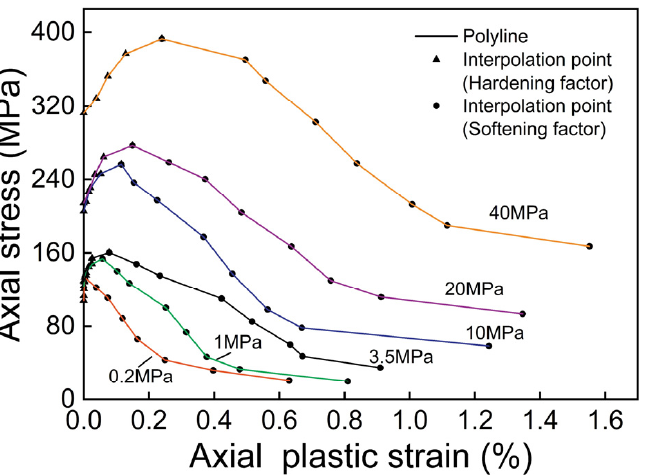
Figure 3. Relationship between hardening factors and softening factors and axial plastic strain under different confining